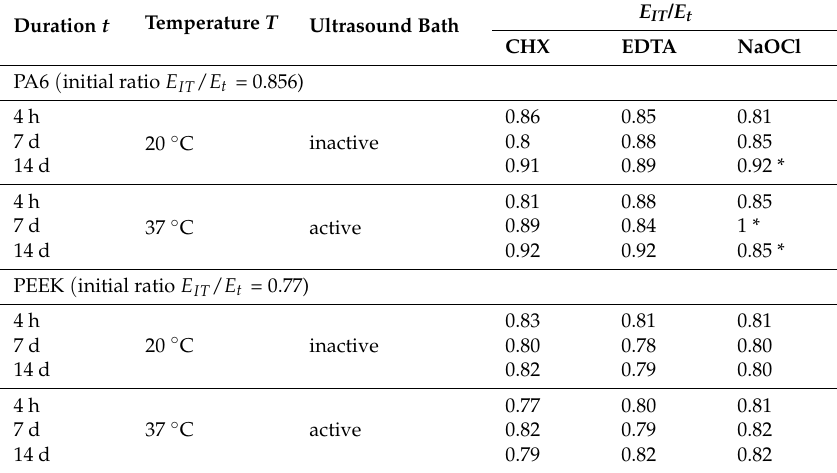
Figure 6. Alteration of indentation modulus 𝐸 𝐼𝑇 (dried samples) after different storage times: ( a ) PA6 at 𝑇 = 20 °C; ( b ) PEEK at 𝑇 = 20 °C; ( c ) PA6 at 𝑇 = 37 °C and ultrasonic excitation; ( d ) PEEK at 𝑇 = 37 °C and ultrasonic excitation. Table 2. Deviations between indentation modulus 𝐸 𝐼𝑇 (median value) and Young’s modulus measured by tensile testing 𝐸 𝑡 from [39,43].